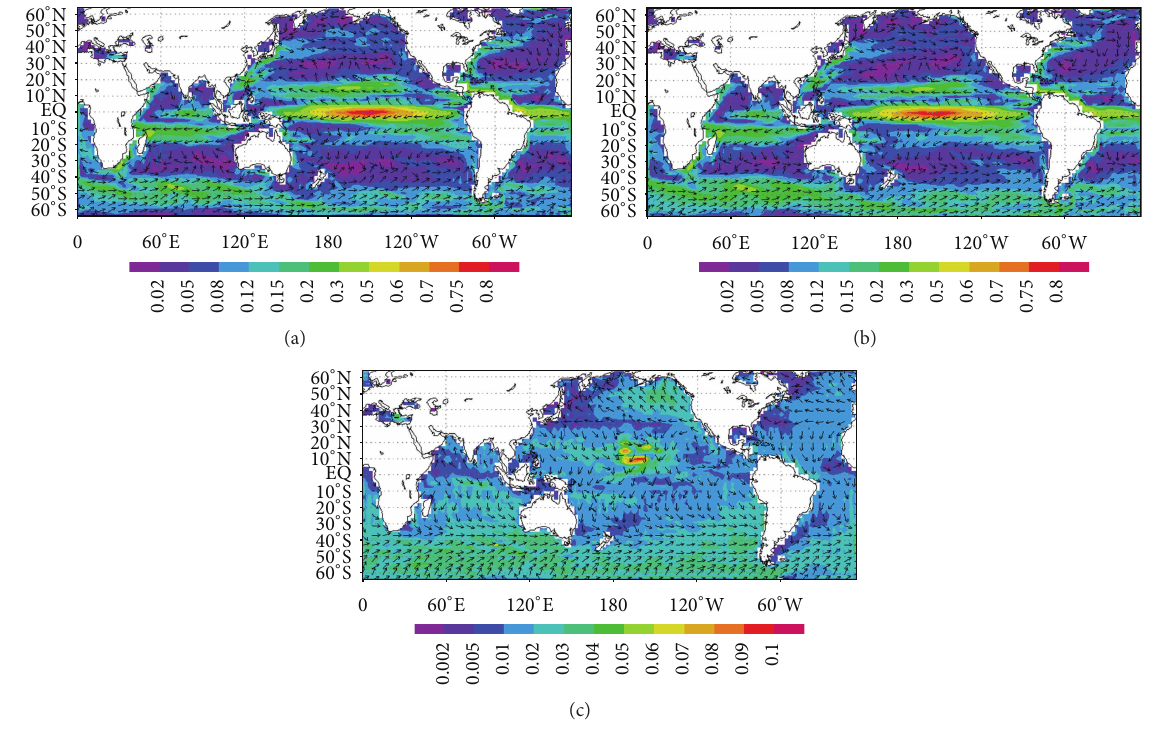
Figure 1: (a) Annual-mean mixed layer current field of 2001 from Exp. 1, in which CSF is not included as a top boundary condition; (b) annual-mean mixed layer current field of 2001 from Exp. 2, in which CSF is considered; (c) annual-mean changes (results of Exp. 2 minus that of Exp. 1) in mixed layer current. Currents (m/s) are vertically averaged through the mixed